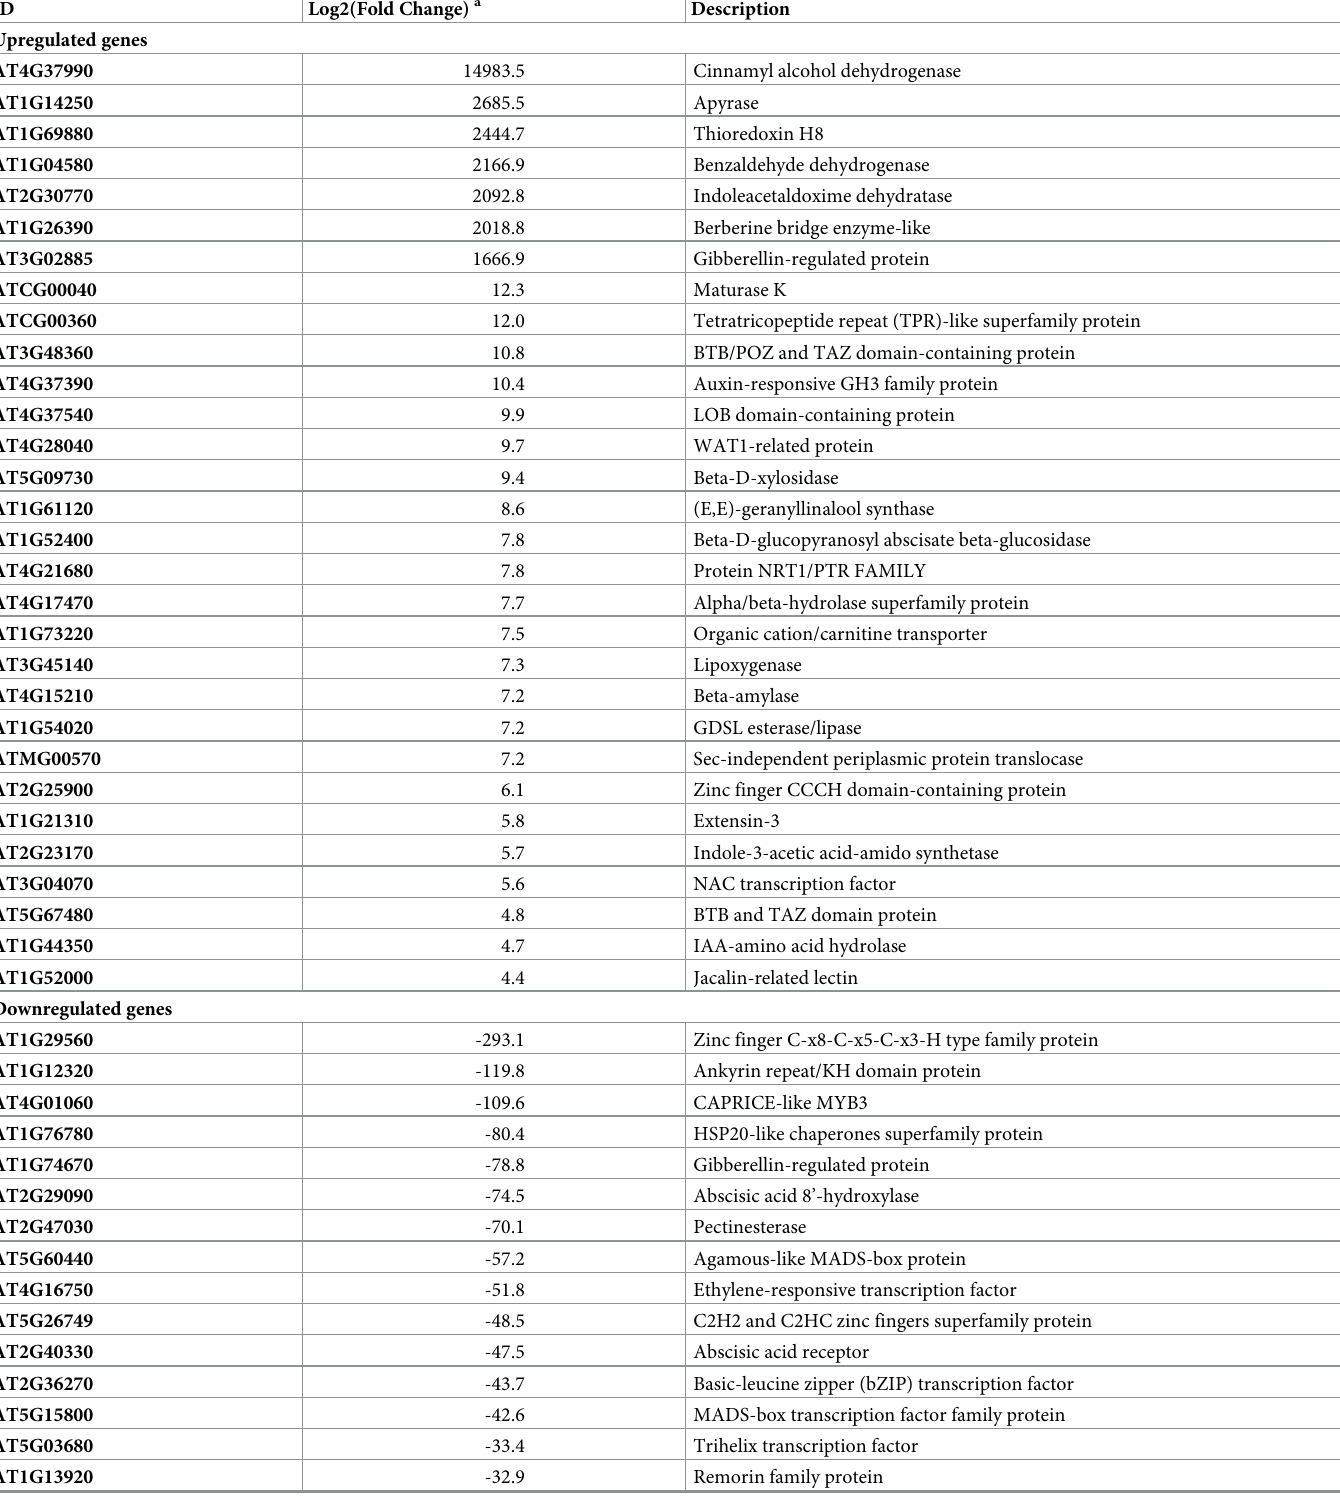
Table 1. Significantly differentially expressed genes during the B . aryabhattai -Arabidopsis